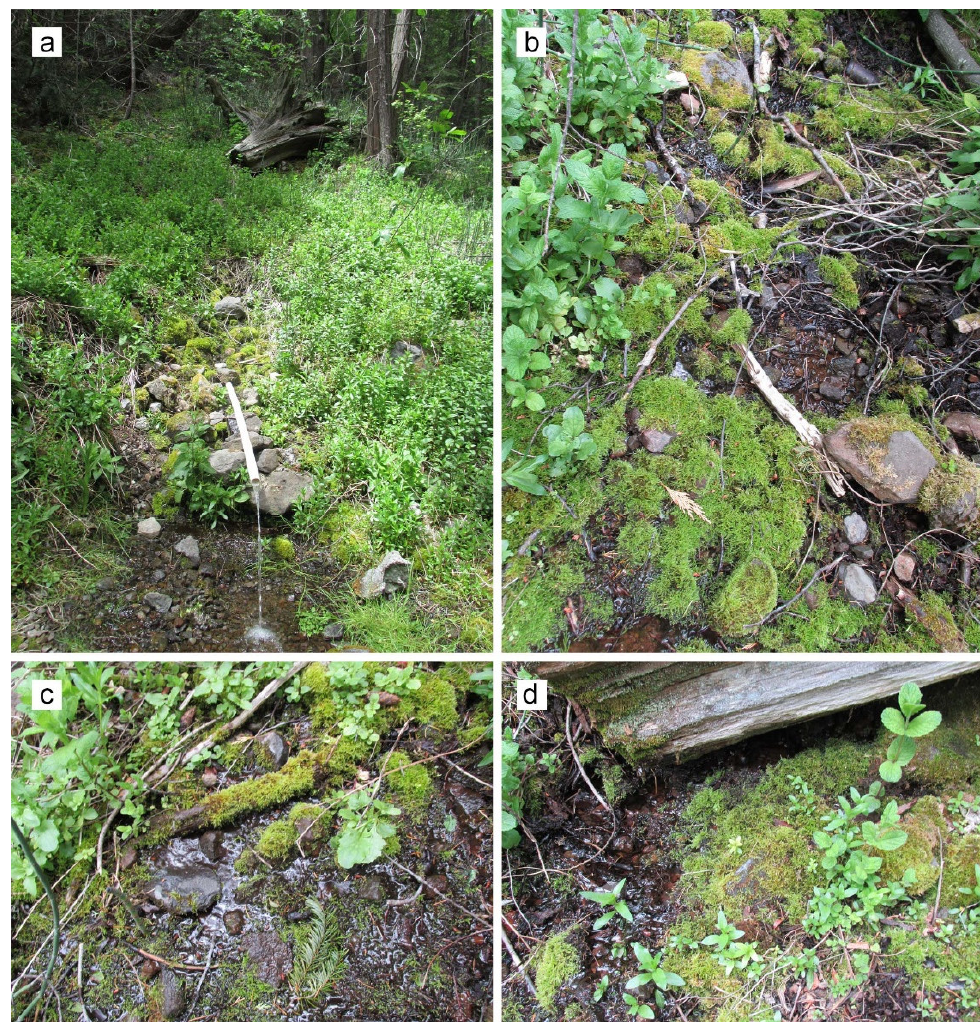
Figure 6. Habitat of Araeopidius monachus (LeConte, 1874). ( a–d ) USA: California: Tehama Co.; High- way 32 mile marker 269, 31 mi N of Chico, unnamed seep/spring, 1096 m, 40°04.632’ N 121°35.760’ W. Table 1. Collection of larval A. monachus arranged by months (n = 12). Measurements are in milli- meters. AbdT IX-abdominal tergite IX; *—taken from [1].